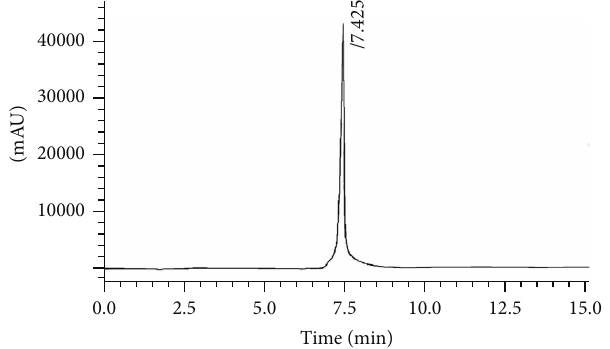
Figure 15: HPLC chromatograph for 2,4,6-TNP.